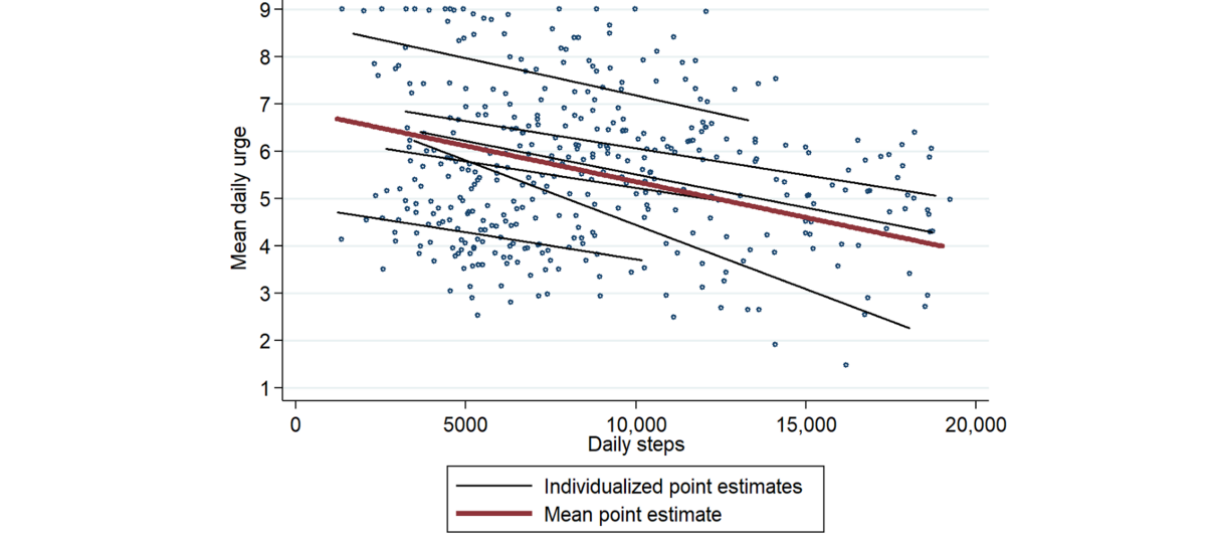
Figure 3. Mean urge per day plotted against daily steps for the 6 “extreme responders,” after applying exclusion criteria and omitting